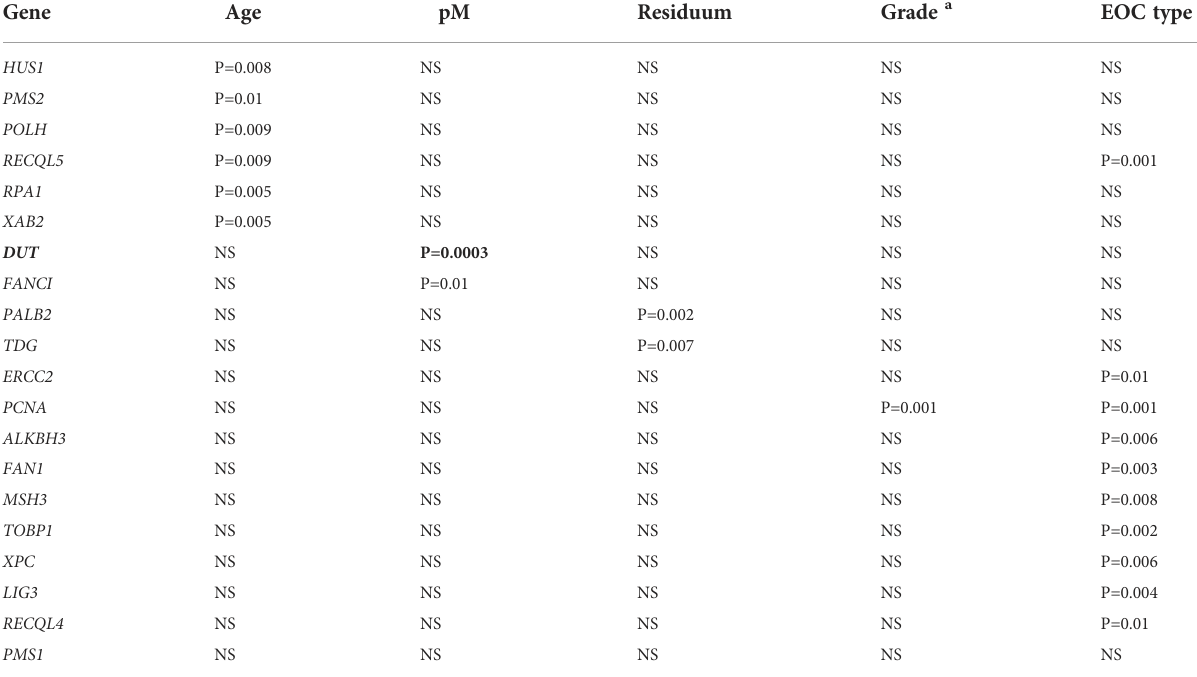
TABLE 2 The signi fi cant associations of DNA repair gene expression pro fi les with clinical data of EOC patients (N = 60, only signi fi cant results with P ≤ 0.01 are shown).